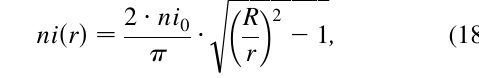
FIG. 8. (Color) Model of the initial H